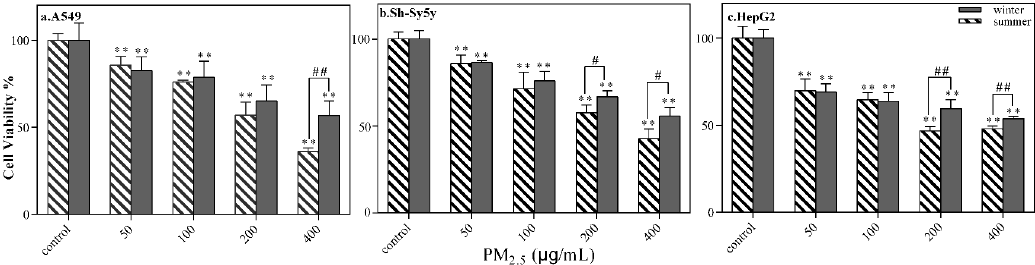
Figure 5. Cell viability of A549, Sh-Sy5y and HepG 2 cells exposed to different concentrations of PM 2.5. (* p < 0.05, ** p < 0.01: Significant differences between each treatment group and the control group was; #p < 0.05, ## p < 0.01: Significant differences between summer and winter samples). Table 3. LC 20 and LC 50 ( μ g/mL) of PM 2.5 in summer and winter.